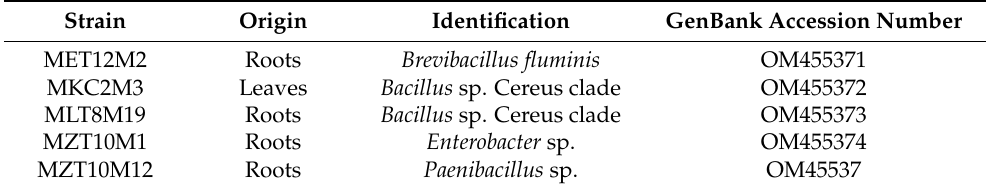
Table 1. Identification based on 16S rDNA partial sequences of strains isolated from strawberry leaves and roots that were efficient in in vitro